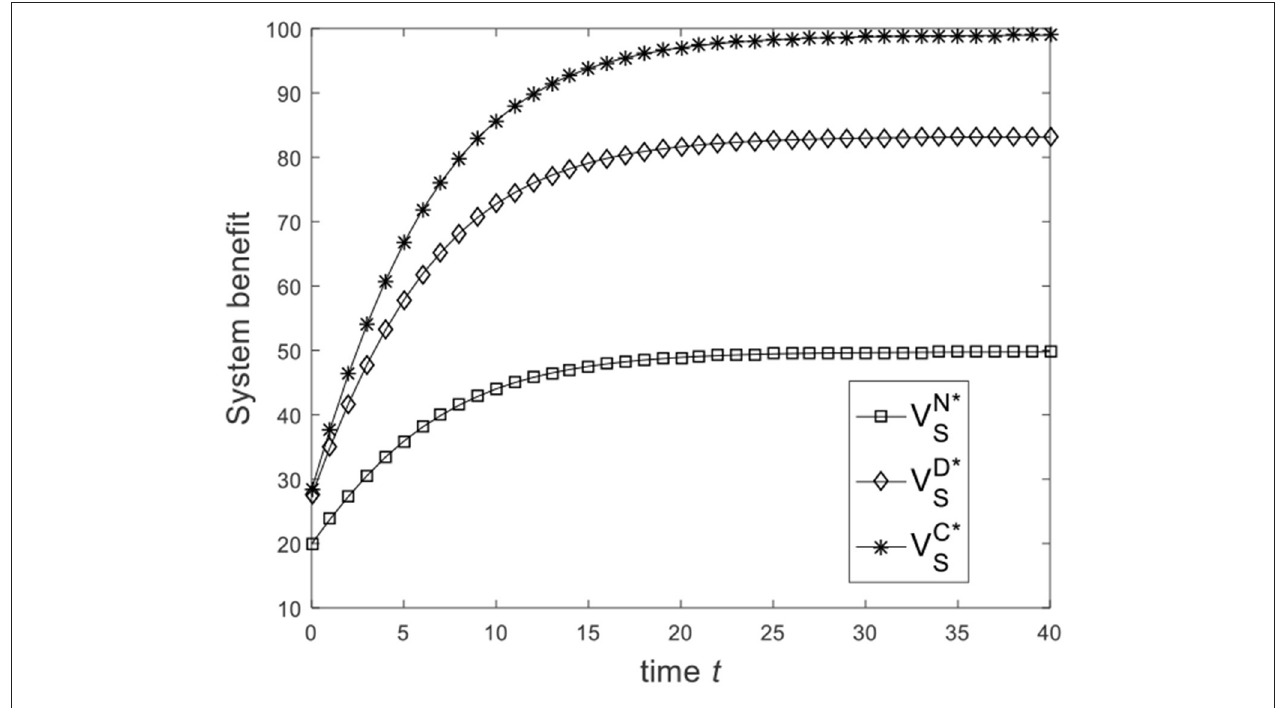
FIGURE 5 | Diagram of the system benefit for ω